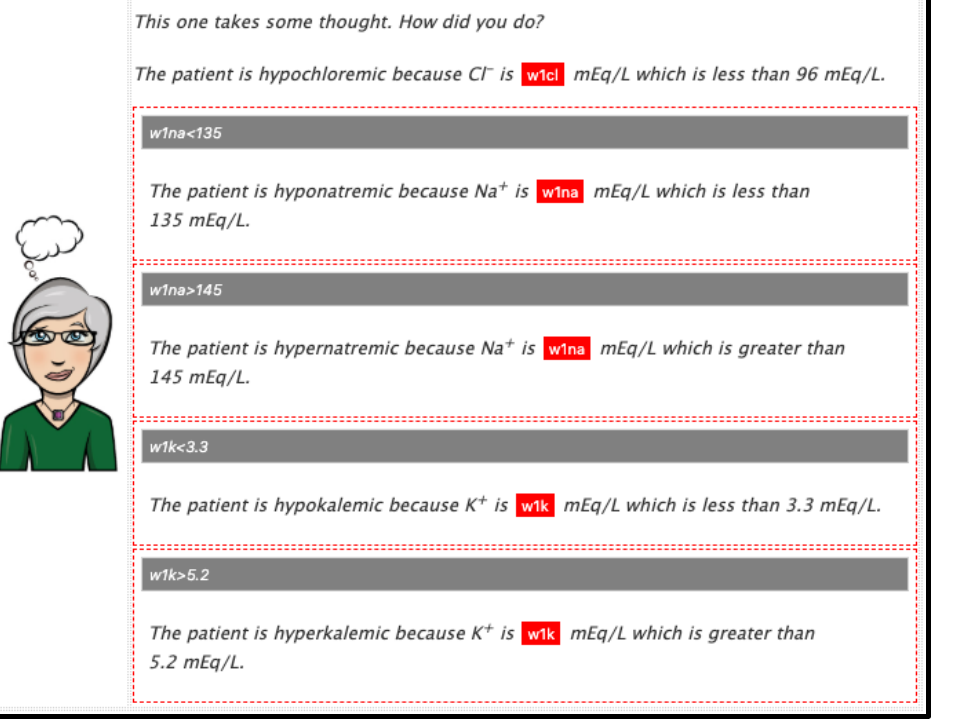
Figure 7. An example of an adaptive case study with varying feedback that embeds numerical variables. Adapted from NUR3125: Pathophysiology for Nursing Practice , by J. Hinkle, 2017, Orlando, FL: University of Central Florida. Copyright 2017 from the University of Central